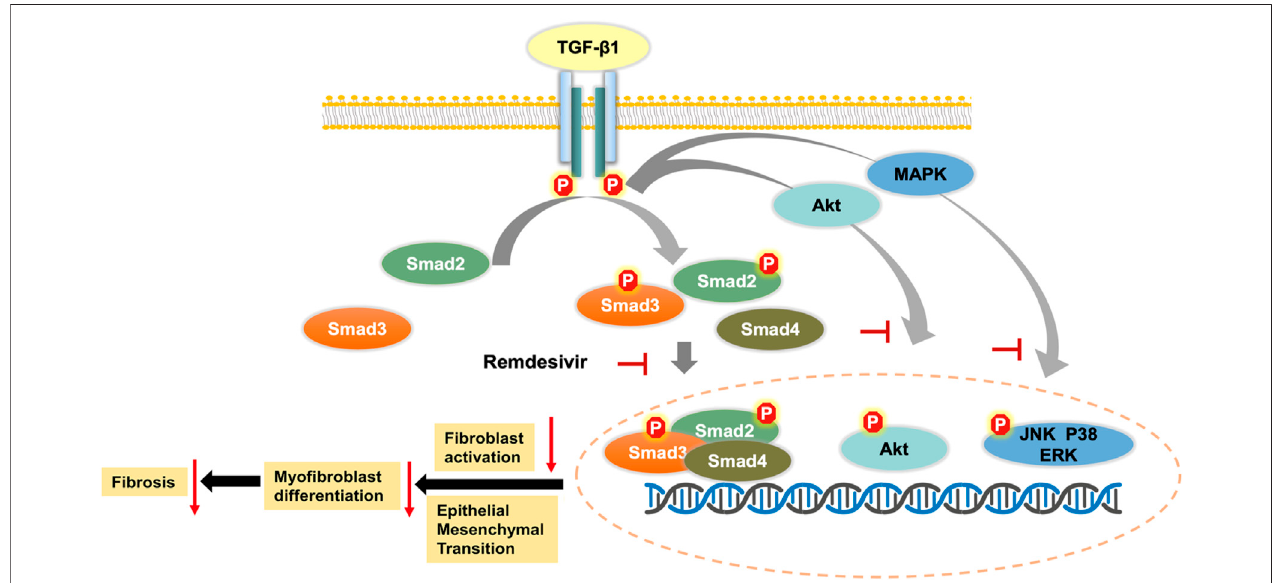
FIGURE 11 | Mechanism for the anti-pulmonary fi brosis effect of